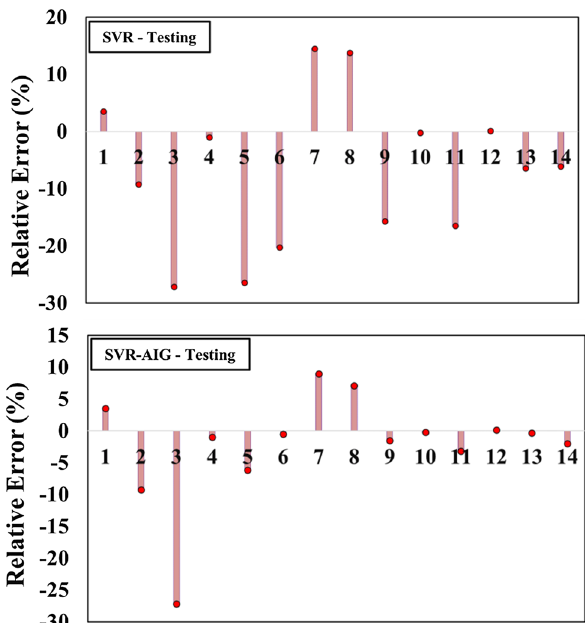
Fig. 5 Relative error plots of the models for testing period